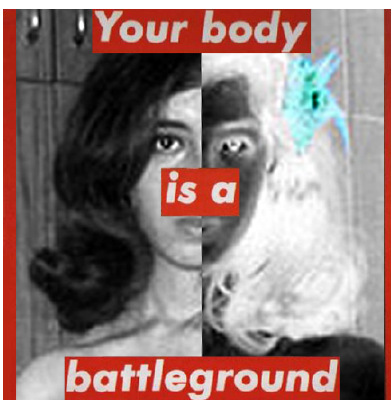
Figure 2. Composition submitted to Elmahdy’s blog “A Rebel’s Diary” by online supporters who remixed a close- up of Elmahdy’s face upon the historical photo-based work of the established artist Barbara Kruger